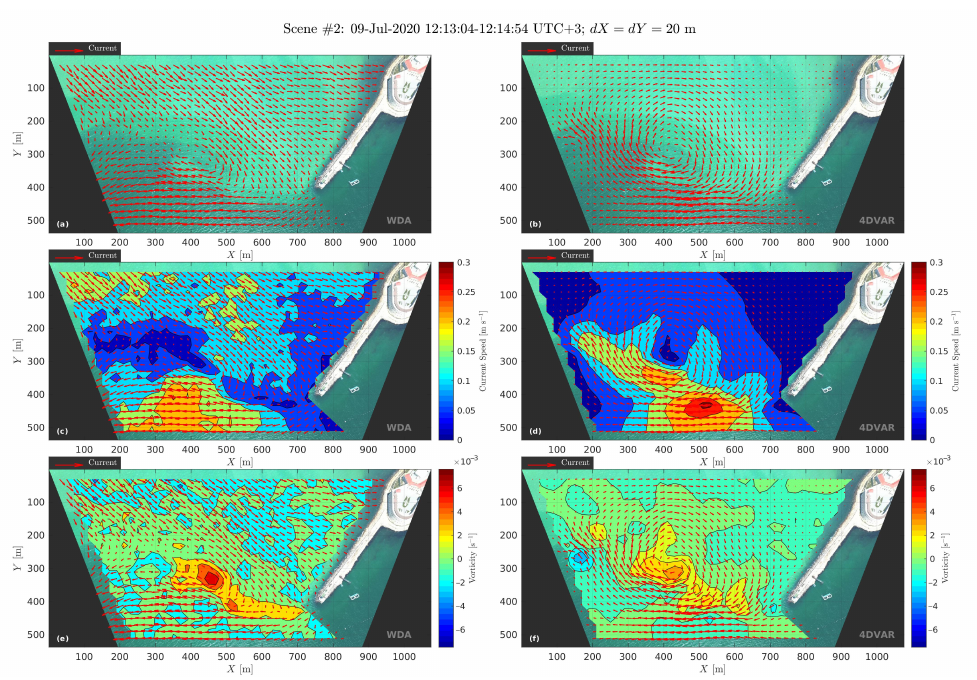
Figure 9. Sea surface current (SSC) maps for Scene #2 estimated using wave dispersion analysis (WDA) and 4D-variational assimilation (4DVAR): ( a , d ) SSC quiver map; ( b , e ) SSC magnitude; and ( c , f ) SSC